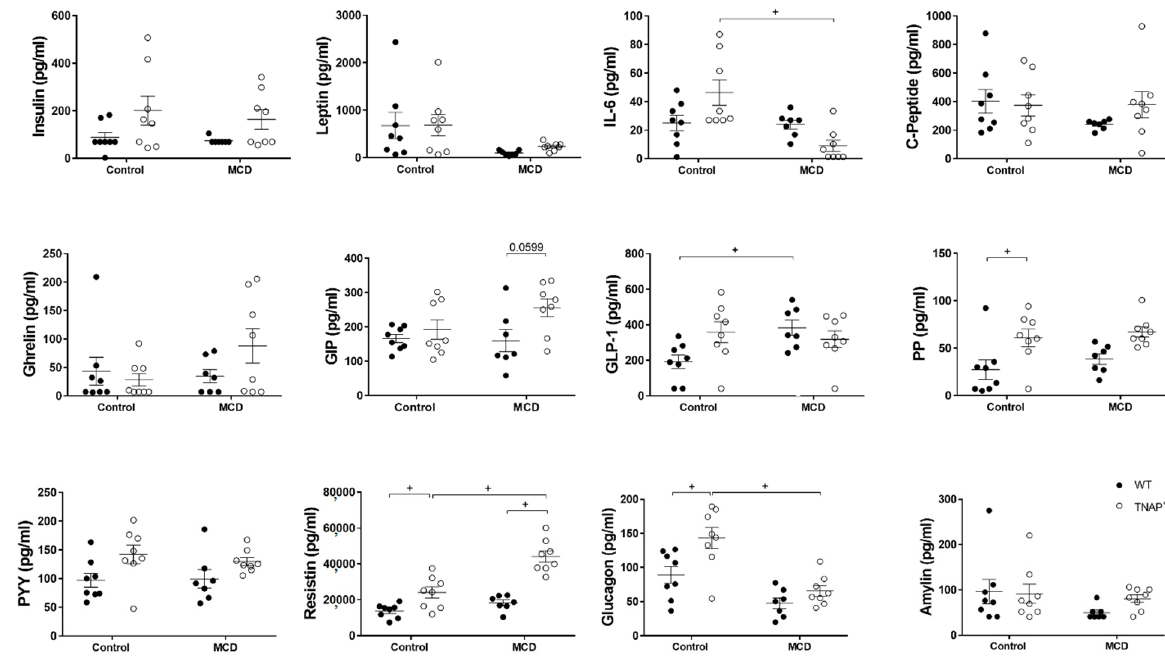
Figure 5. Plasma concentration of inflammation-, obesity- and steatosis-related markers in wild-type (WT) and TNAP heterozygous mice (TNAP +/ − ) fed a control diet (10% w/w fat, control) or the same diet deficient in choline and methionine (MCD). Results from the Metabolic Hormone Expanded Panel multiplex are shown. + p < 0.05.